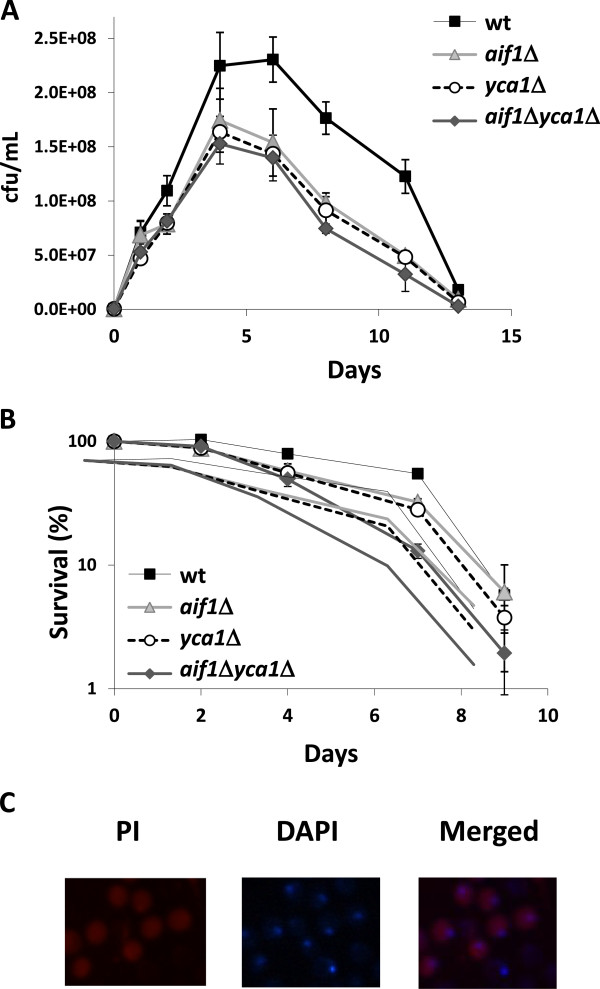
Deletion of apoptosis-related genes shortens CLS under winemaking conditions. The deletion mutants of YCA1, AIF1, or both, on the C9 strain were used for grape juice fermentations. A) Cell viability over time was measured as cfu/mL. B) Survival curves after taking day 4 of fermentation as 100% survival. Experiments were done in triplicate and the mean and standard deviation are provided. C) C9 strain after 8 days of fermentation was co-stained with propidium iodide (PI) and DAPI, and observed under a fluorescence microscopy. A merged image is also shown.